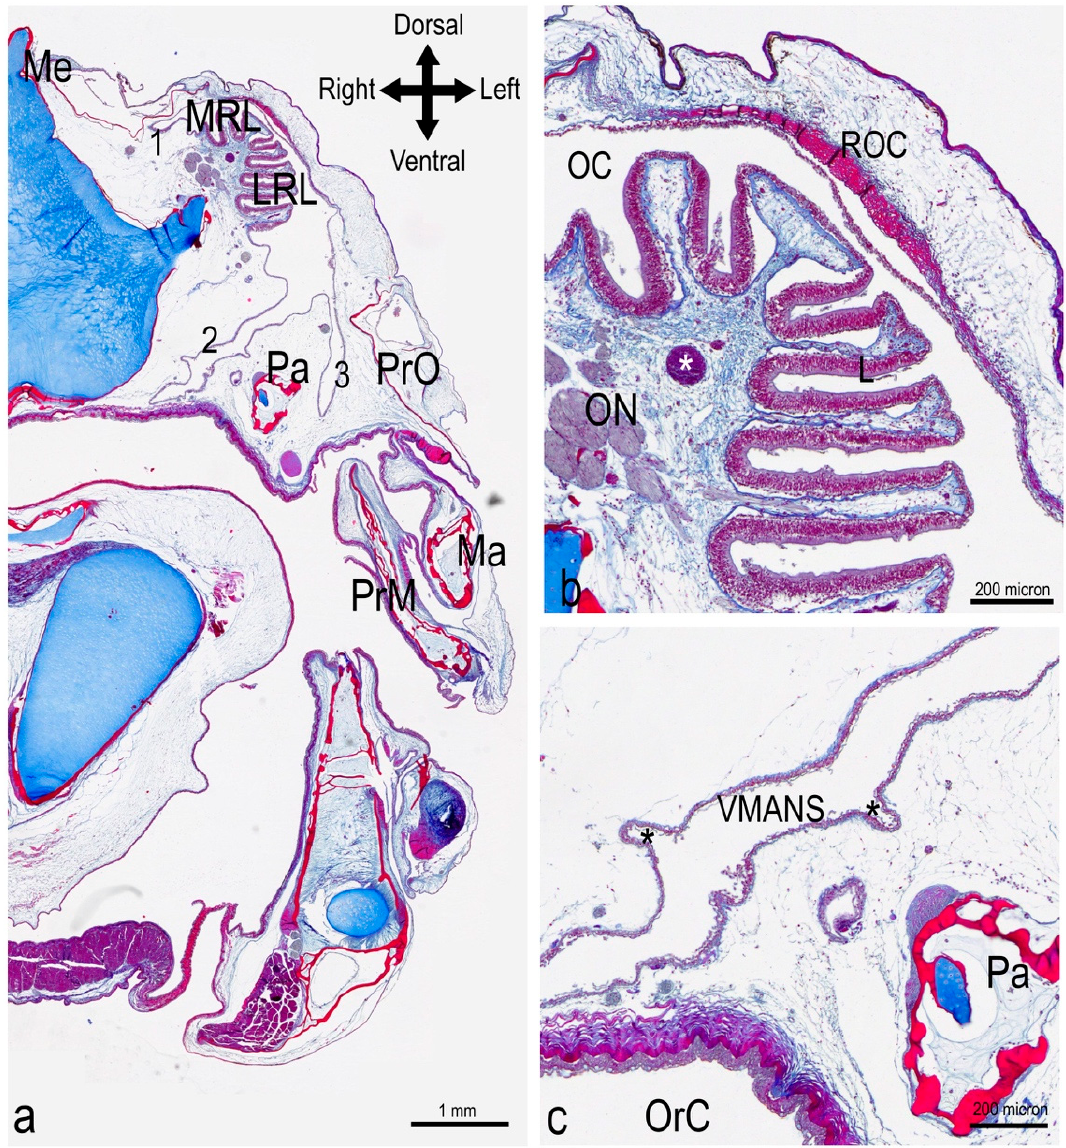
Figure 3. Histology of the head of P. antarcticum . The complete scan of this histological section at 100 × is available in Supplementary File S1. Transverse cutting plane. Azan Trichrome. ( a ) Complete section of half head; level indicated by the third line (with asterisk) in Figure 2a. The olfactory rosette is obliquely positioned in the nasal chamber, with the medial row of lamellae (the shorter row) being dorsal to the lateral (and longer) row of lamellae. The olfactory chamber is in continuity with accessory nasal sacs, which are narrow and branched. The ventromedial accessory nasal sac (number 2) runs internally to the palatine bone and reaches the roof of the mouth, being divided from the oral cavity by the oral mucosa. The ventrolateral accessory nasal sac (number 3) runs between the palatine and the preorbital bones. ( b ) Detail of the photograph in ( a ). The roof of the main nasal chamber is characterized by a thicker layer of fibrous connective tissue, compared to the rest of the wall of the main and accessory nasal sac. A large blood vessel (asterisk) is visible running along the raphe. ( c ) Detail of the photograph in ( a ). The ventromedial accessory nasal sac presents some diverticula of unknown function (asterisks). LRL = lateral row of lamellae; Ma = Maxilla; Me = mesethmoid; MRL = medial row of lamellae; OC = olfactory chamber; OrC = oral cavity; ON = olfactory nerve; Pa = Palatine bone; PrM = premaxilla; PrO = Preorbital bone; ROC = roof of the olfactory chamber; VMANS = ventromedial accessory nasal sac.